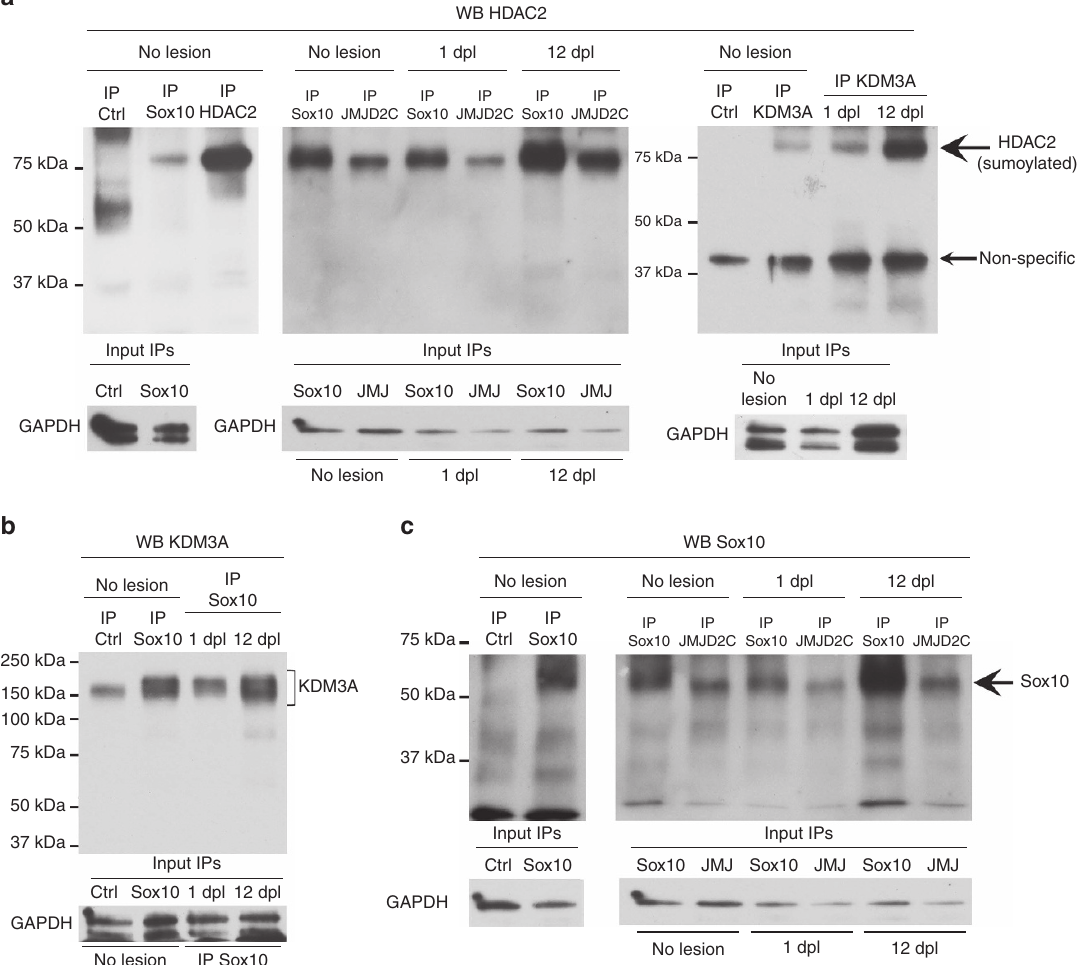
Figure 8 | Assembly of multifunctional protein complex. ( a – c ) Non-denaturing IP of Sox10, HDAC2, JMJD2C, KDM3A or ctrl (GFP or Flag) in unlesioned (no lesion) adult mouse sciatic nerve lysates or at 1 dpl or 12 dpl, and western blot of HDAC2 ( a ), KDM3A ( b ) or Sox10 ( c ). Membranes where Sox10 and JMJD2C IPs were run together were first blotted with the HDAC2 antibody ( a ) and were re-blotted with the Sox10 antibody ( c ). GAPDH western blots on lysates used for IP show the inputs (in a , only one input for no lesion IP KDM3A and ctrl that were done on the same lysate divided by two). Sample size: each IP was done three times, using nerves of three different animals. One nerve was used per